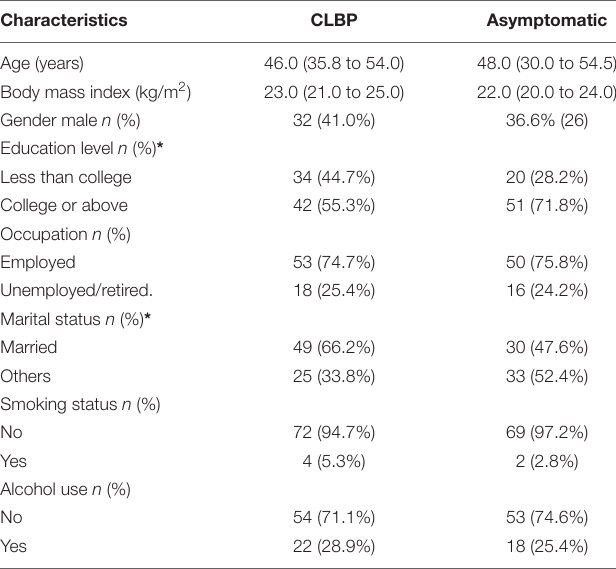
respectively, while 40 and 38% had clinically significant mood and fear-avoidance beliefs problems, respectively. Ten percent and 59% had clinically significant pain-catastrophizing and insomnia, respectively ( Table 2